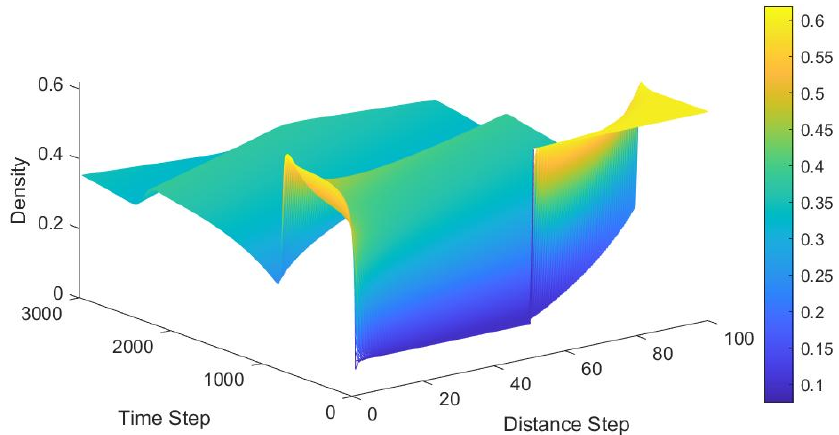
Figure 17. Density behavior of the proposed model on a ring road.